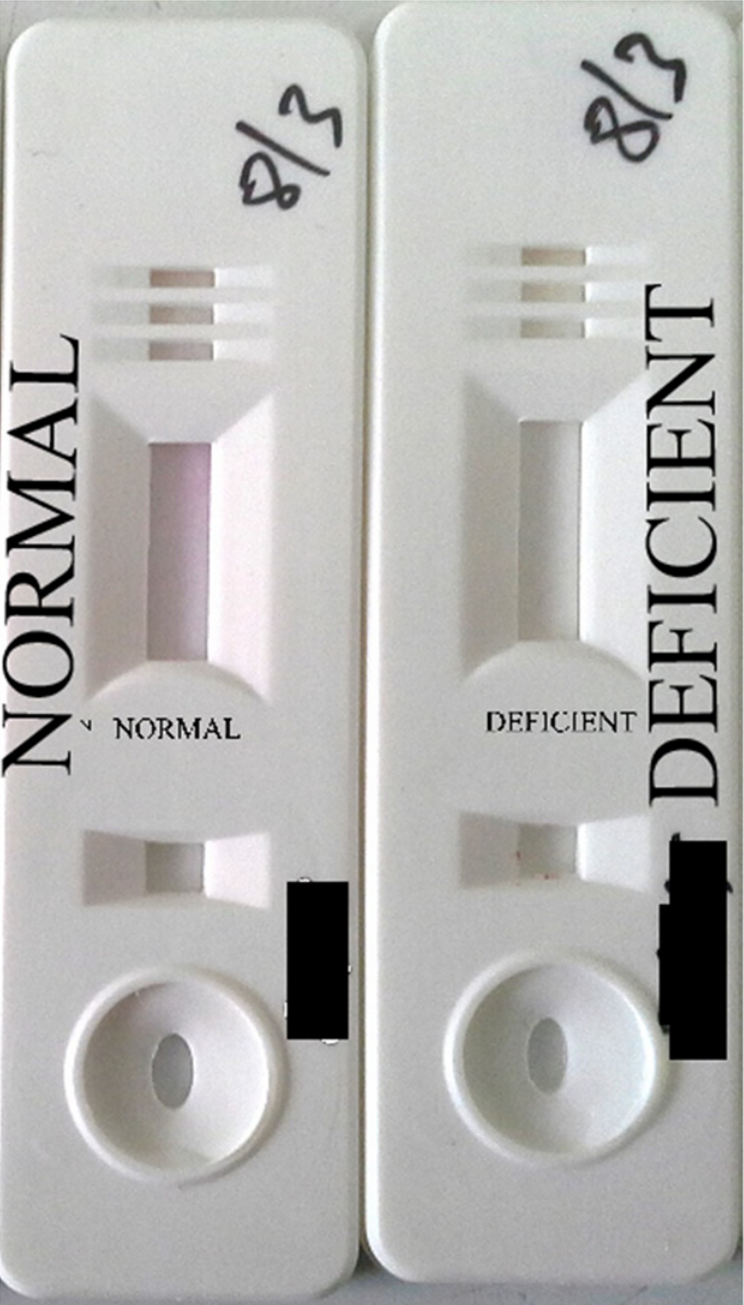
Fig 3. CareStart G6PD RDT screening kit with results interpretation. Results of kit labelled with NORMAL and DEFICIENT interpretation. Full blood count analysis. Full Blood Count was determined using a validated ABX Mi- cros 60 analyzers (Horiba-ABX, Montpellier, France) to obtain the haemoglobin concentra- tion, Red Blood Cells and White Blood Cell count levels of participants were used in the calculation of the G6PD activity in the erythrocytes and malaria parasite density.